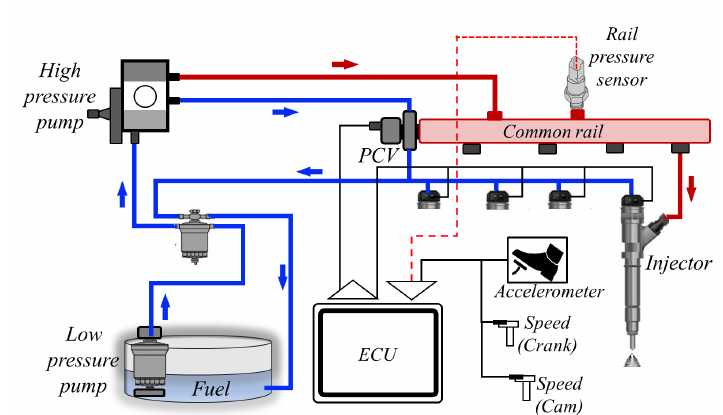
Figure 1. A typical common rail diesel fuel injection system.